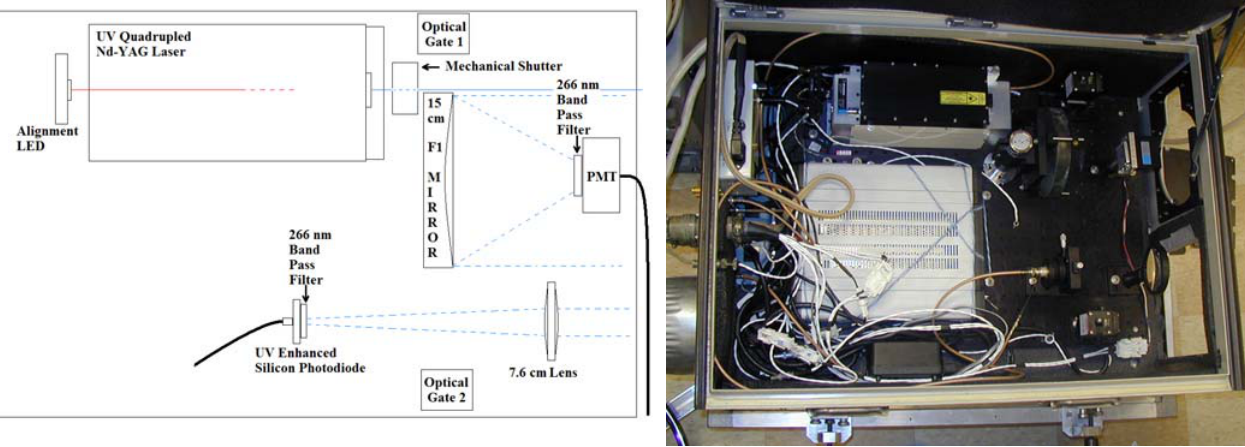
Figure 2. Diagram and picture of the main unit of the UV LiDAR/transmissometer